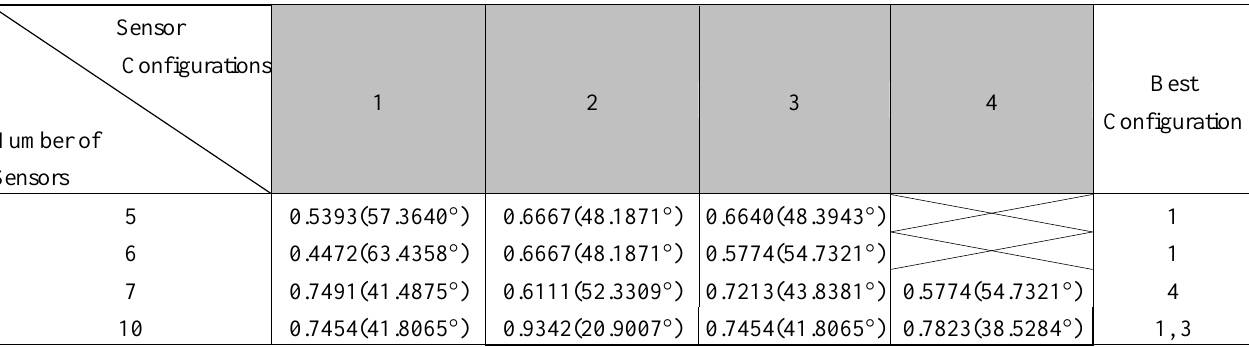
Table 7. Best configuration for both navigation and FDI performance in Tables 3 through